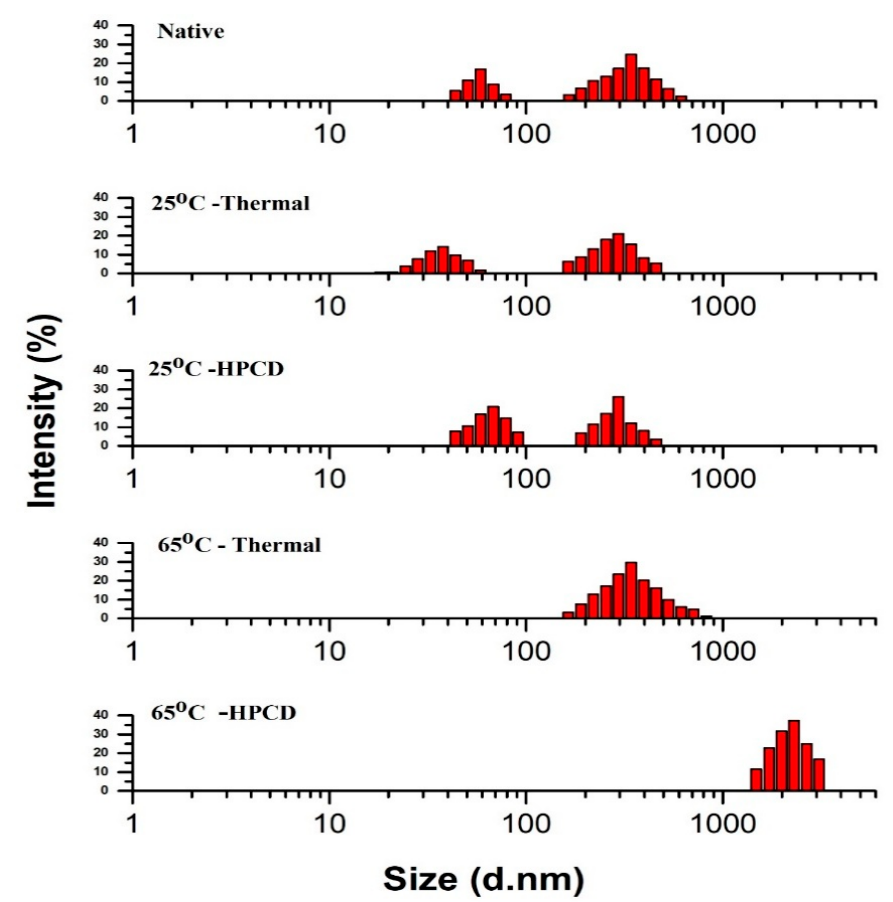
Figure 3. Particle size distributions of native PPO in comparison to thermal- and HPCD-treated PPO.